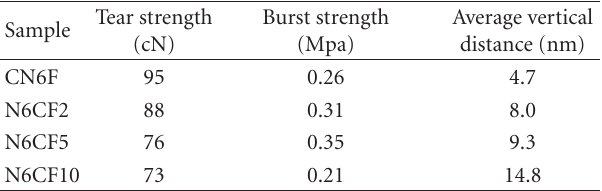
Table 5: Nylon 6 film TGA, tear strength and burst strength